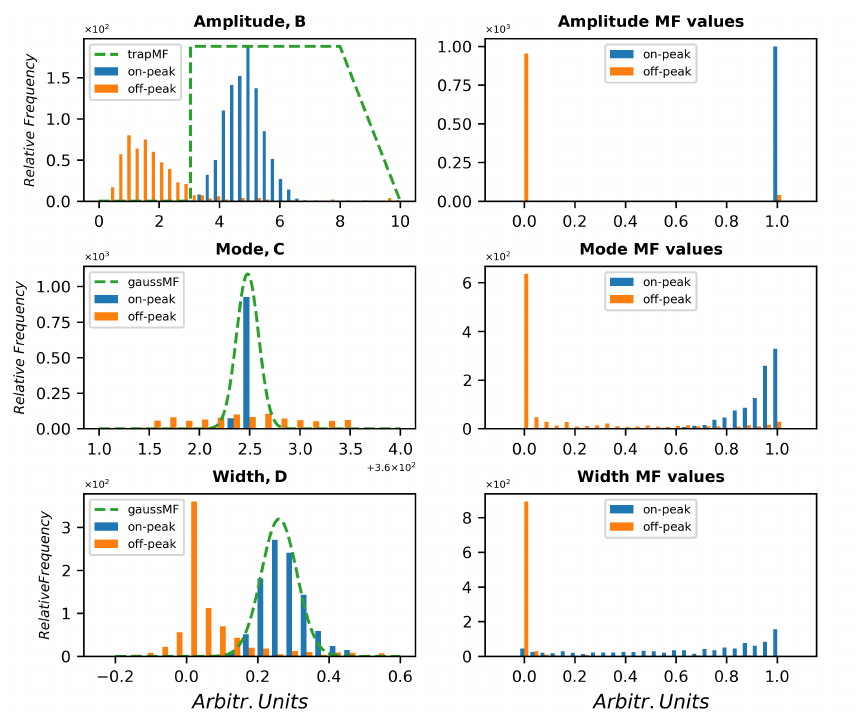
Figure 5. Distribution of the parameters B, C, D of the Lorentzian fit together with hypothetic fuzzy membership functions ( top ) and distribution of the fuzzy belonging degrees of each parameter according to the FMFs shown ( bottom